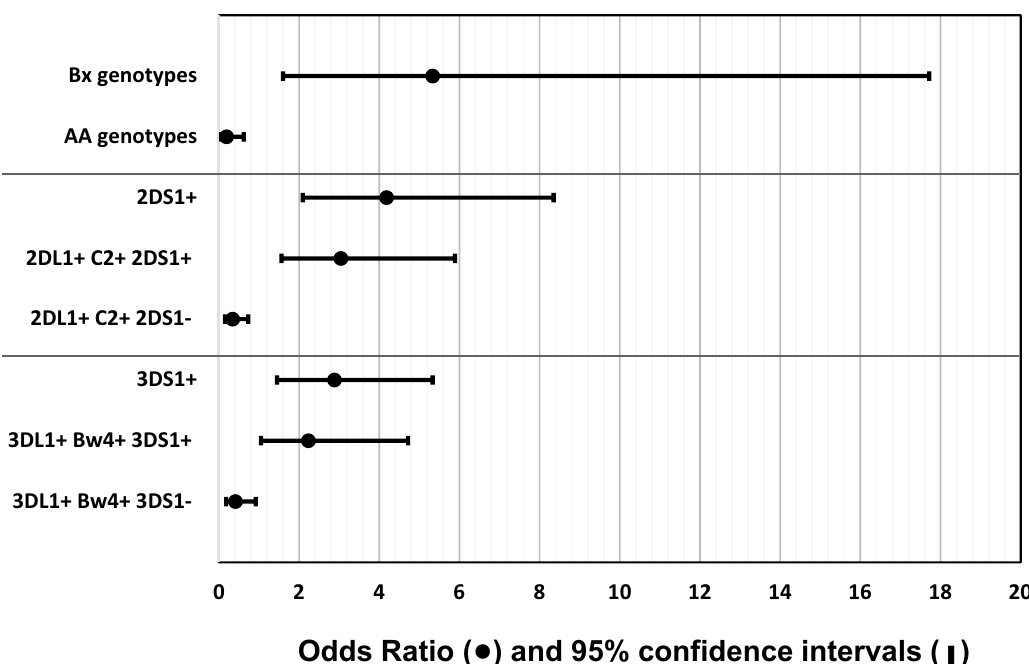
Figure 3. Selected KIR and HLA association with advanced-stage breast cancer. Forest plot depicting odds ratios (circles) with 95% confidence intervals for the association between selected KIR and HLA genotypes and advanced-stage breast cancer compared to healthy controls.